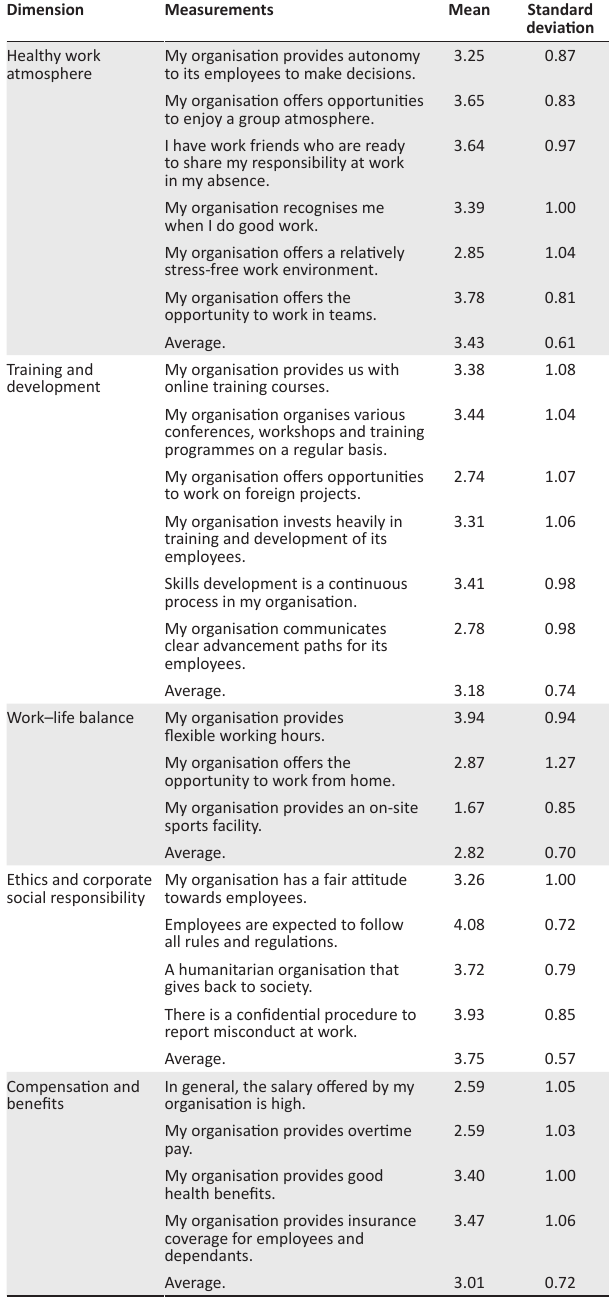
TABLE 1: Employer branding